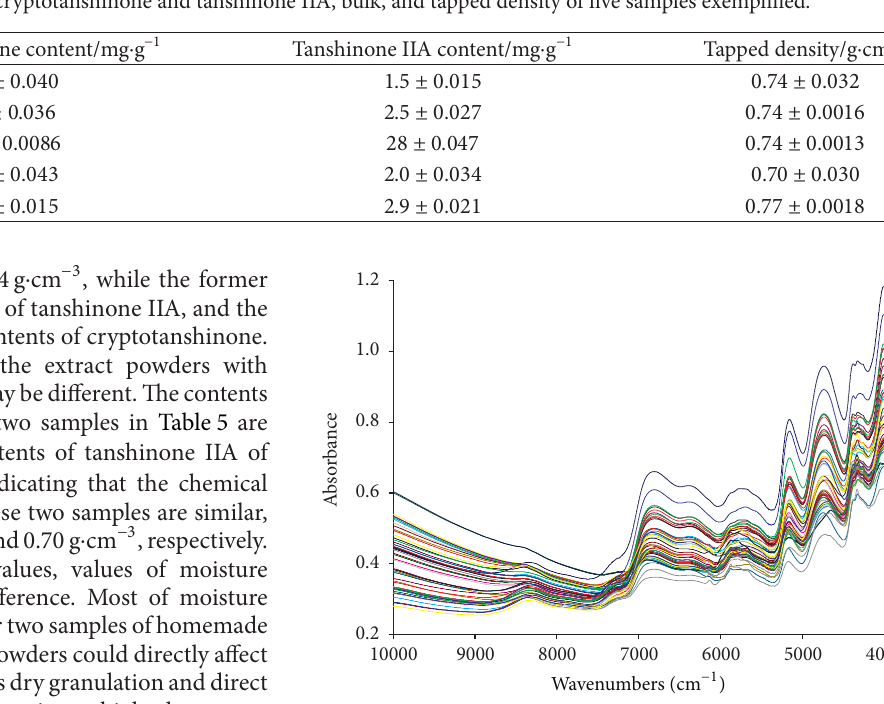
Figure 1: The near infrared spectra of 50 samples without any pretreatment.